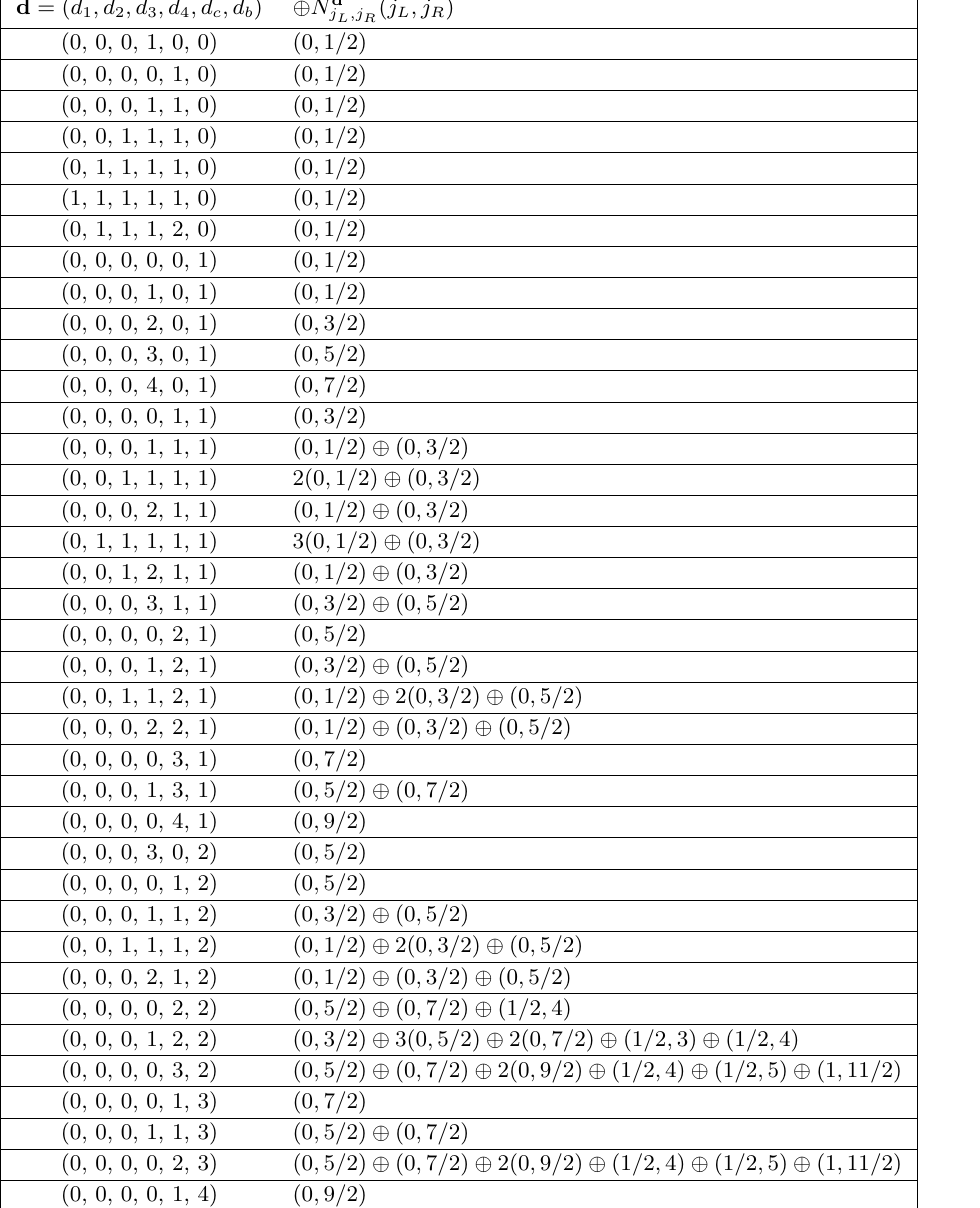
Table 6. BPS invariants of 6d n = 4 minimal